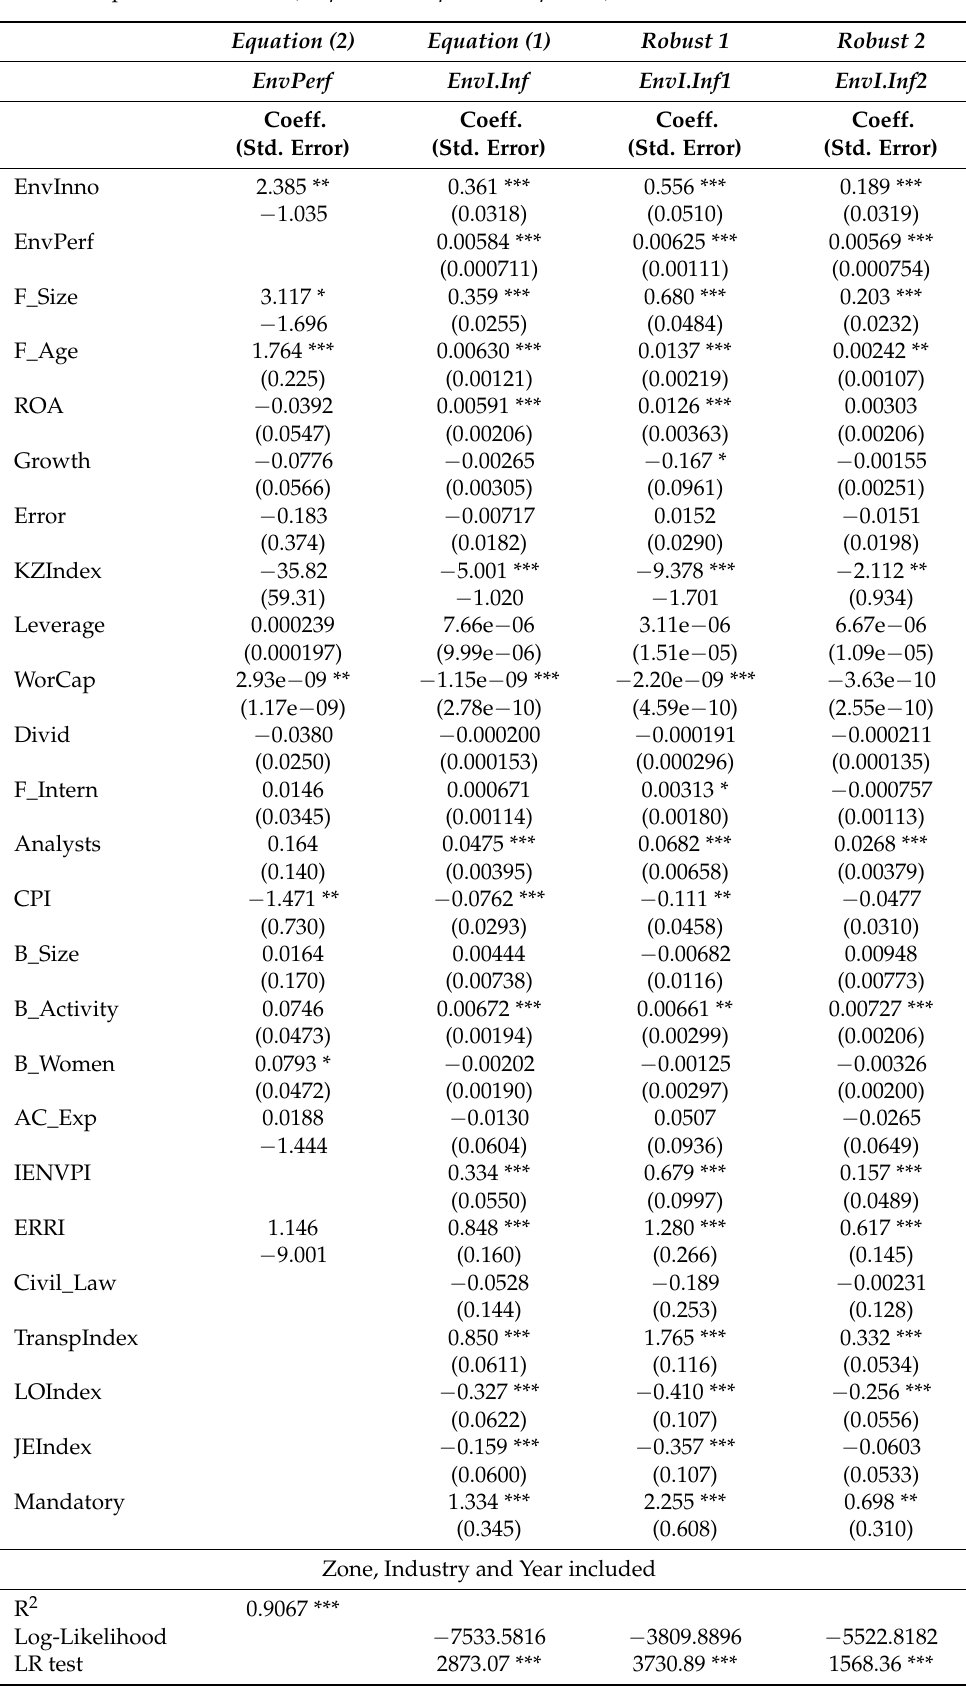
Table 4. Dependence models (*** p < 0.01, ** p < 0.05, * p <